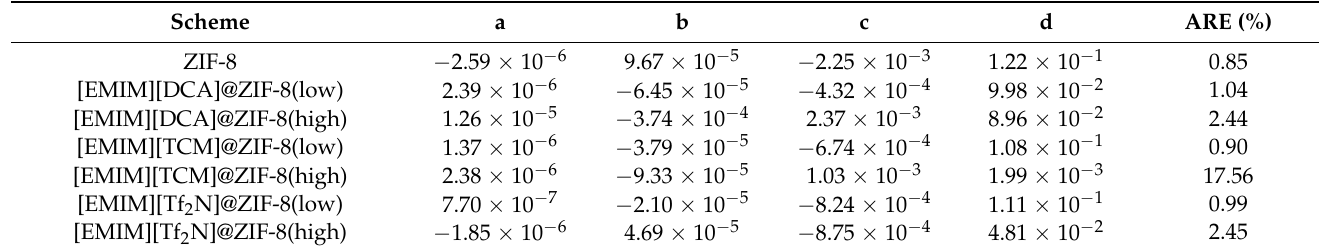
Table A4. N 2 coefficient parameters and global average relative error of the fitting using Equation (3).